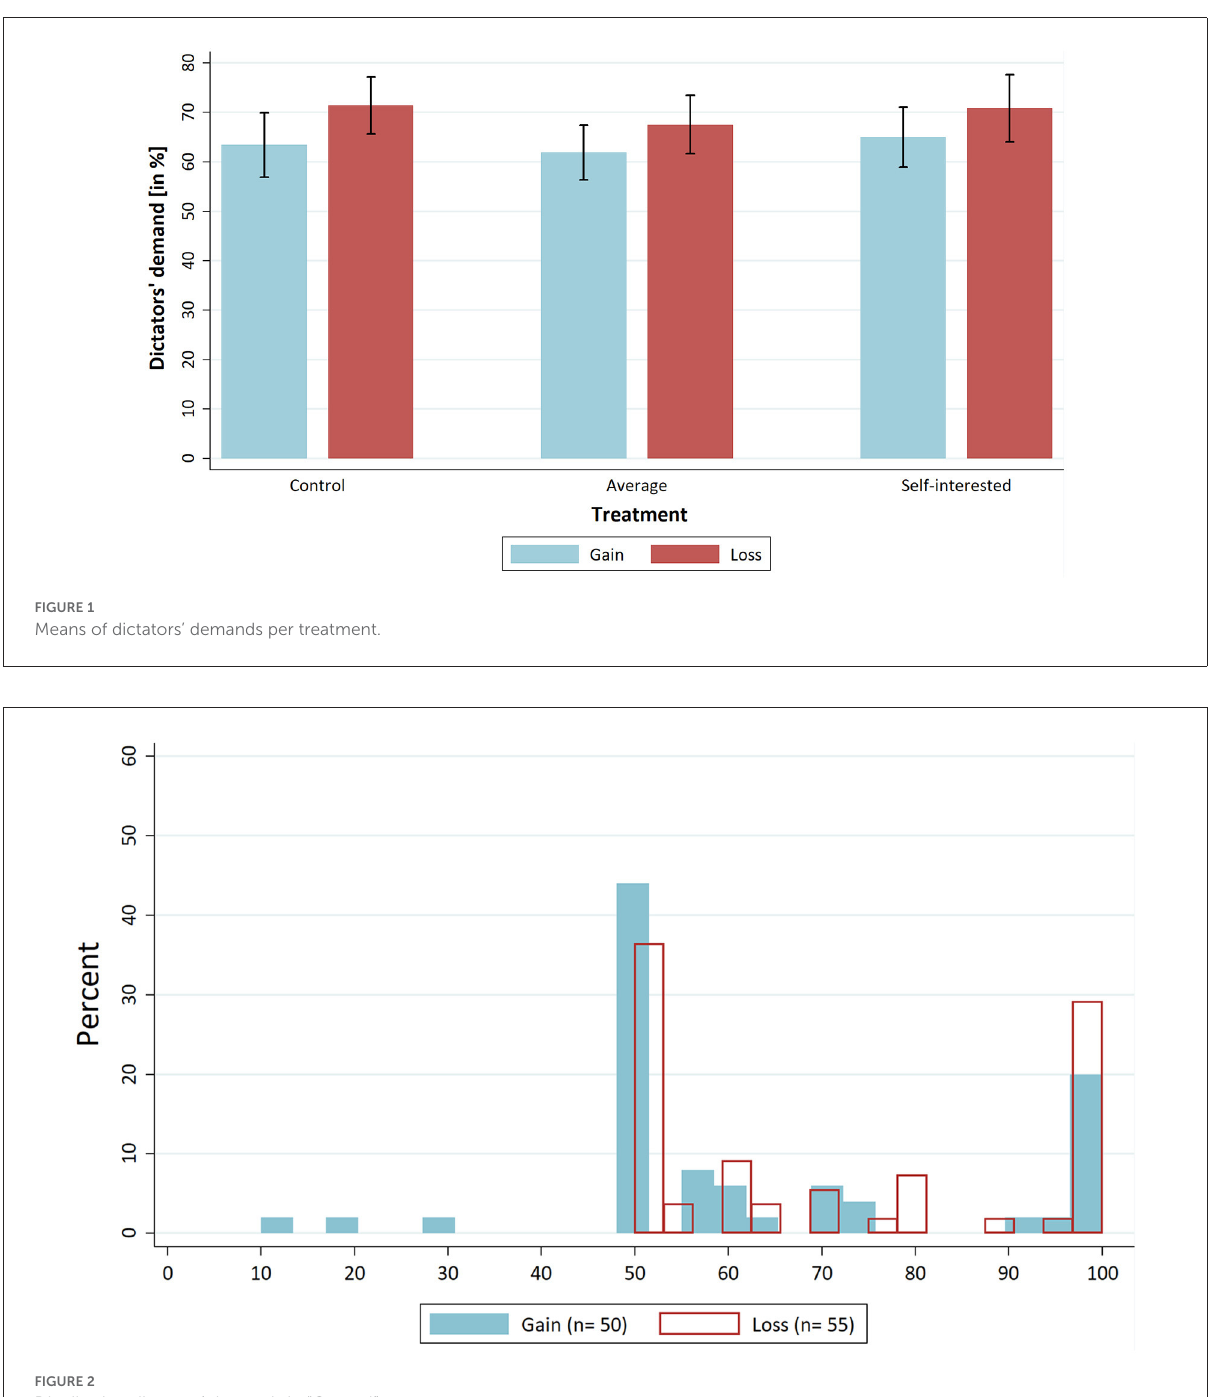
FIGURE2 Distribution dictators’ demands in